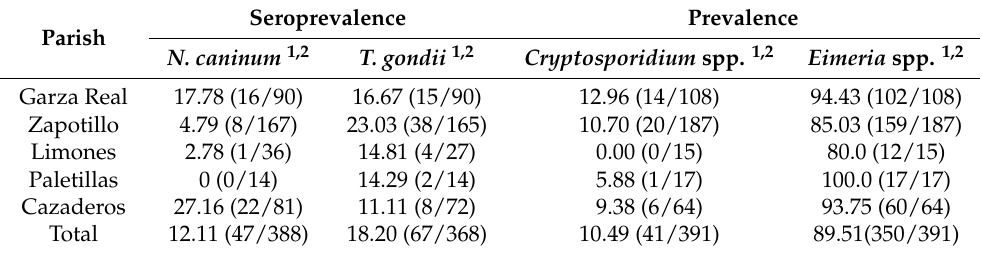
Table 1. Seroprevalence of Neospora caninum and Toxoplasma gondii and prevalence of Cryptosporidium spp. and Eimeria spp. in goats from parishes of Zapotillo Canton,